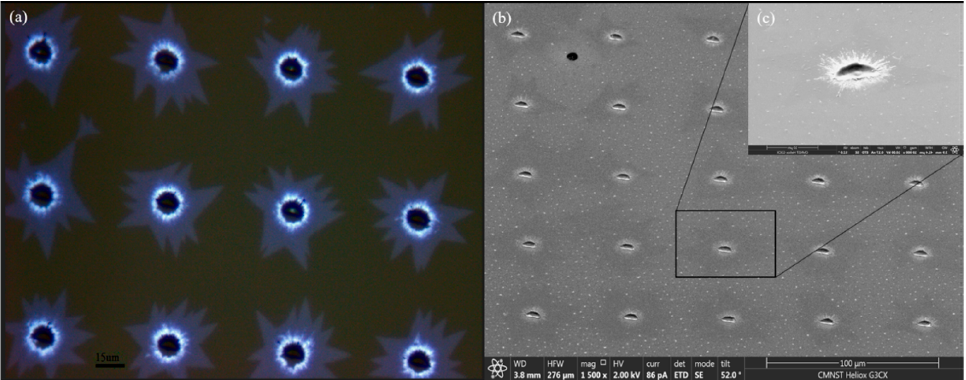
Figure 2. ( a ) OM image, ( b ) SEM image, and ( c ) partial enlarged view of ( b ) showing the periodic growth of MoS2 on sapphire substrate.